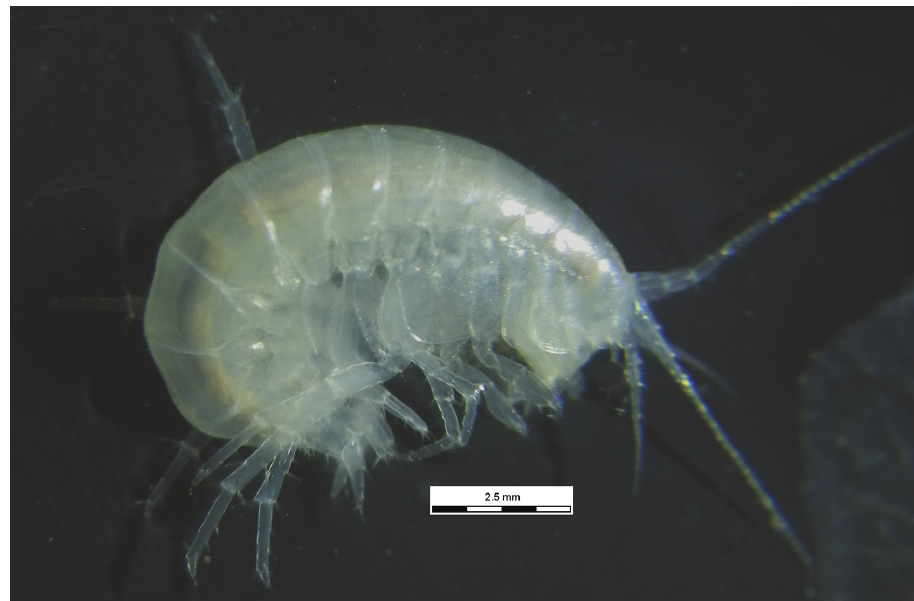
Figure 2. Photograph of live specimen of Zenkevitchia yakovi sp. n. in the cave “Istočnik Tcebel’da”, from right side. Photography by A.